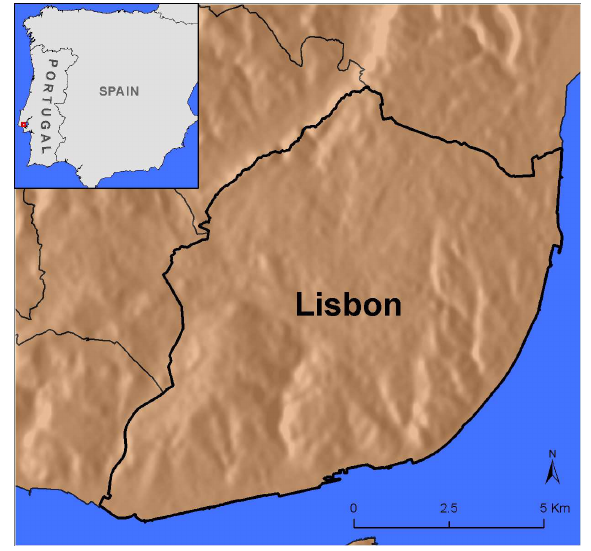
Figure 1. Study area – the municipality of Lisbon, Portugal Lisbon occupies an area of 84 Km 2 , and is a characteristic European capital city, with very diverse land cover/land use and urban morphologies. These range from historical neighborhoods (e.g., the downtown area of Baixa ), where the street network is dense and most of the area is built-up, to modern residential areas (e.g., the area of Alta ), with ongoing construction of roads and multi-family buildings.